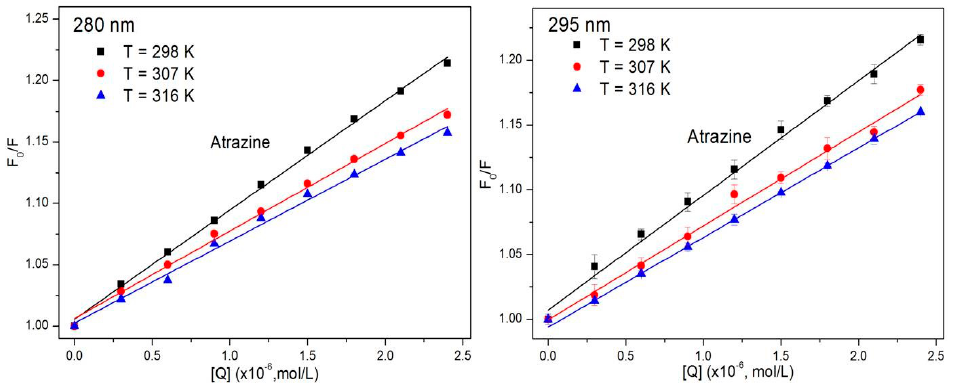
Figure 2. Stern–Volmer plot describing HSA fluorescence quenching caused by ATR at different excitation wavelengths. Data are mean ± SE (bars) ( n = 3) (T = 298 K, 307 K, 316 K).